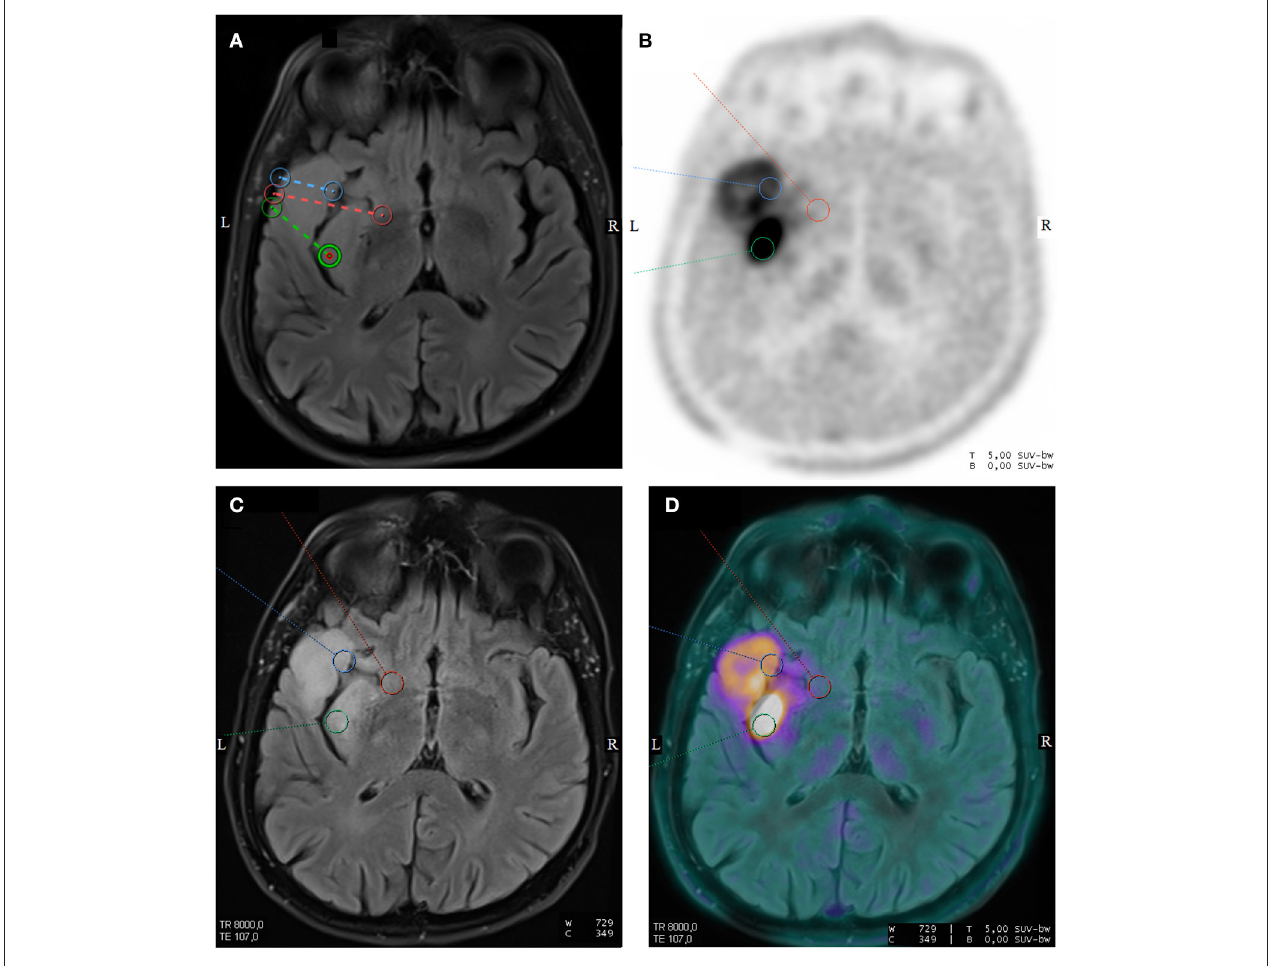
FIGURE 1 | Axial T2-weighted fluid-attenuated inversion recovery (FLAIR) sequence from surgical navigation software with the locations of three neuronavigation-guided biopsies in a 59-year-old man with a left temporal diffuse IDH1-wild-type glioblastoma (A) . Corresponding axial images of FDOPA PET (B) , T2-weighted FLAIR sequence (C) , and fused FDOPA PET/T2-weighted FLAIR sequence (D) are displayed. The pathology grading of the neuronavigation-guided biopsies revealed WHO grade II for the red VOI and WHO grade III for the green and blue